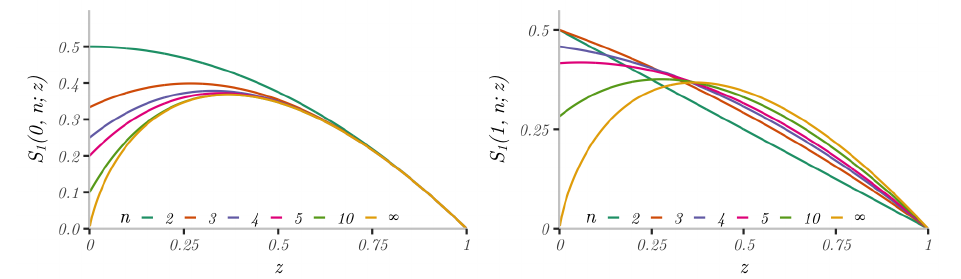
Figure 1. The winning probability S 1 ( k , n ; z ) of z -strategy in the best-choice problem for k = 0 and 1